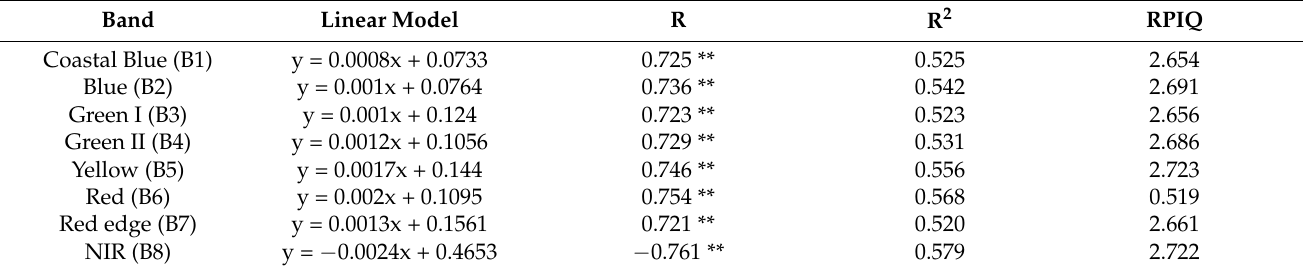
Table 6. Relationships between PlanetScope bands and EC data in the study area (dS m − 1